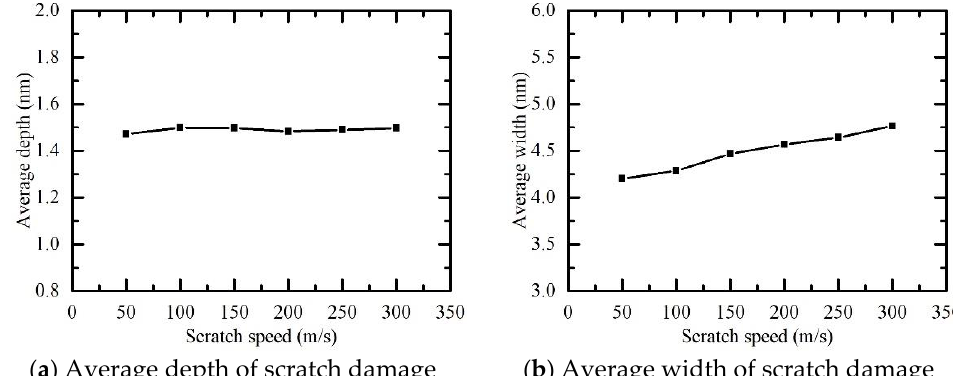
Figure 13. Internal structure with different scratch speeds.